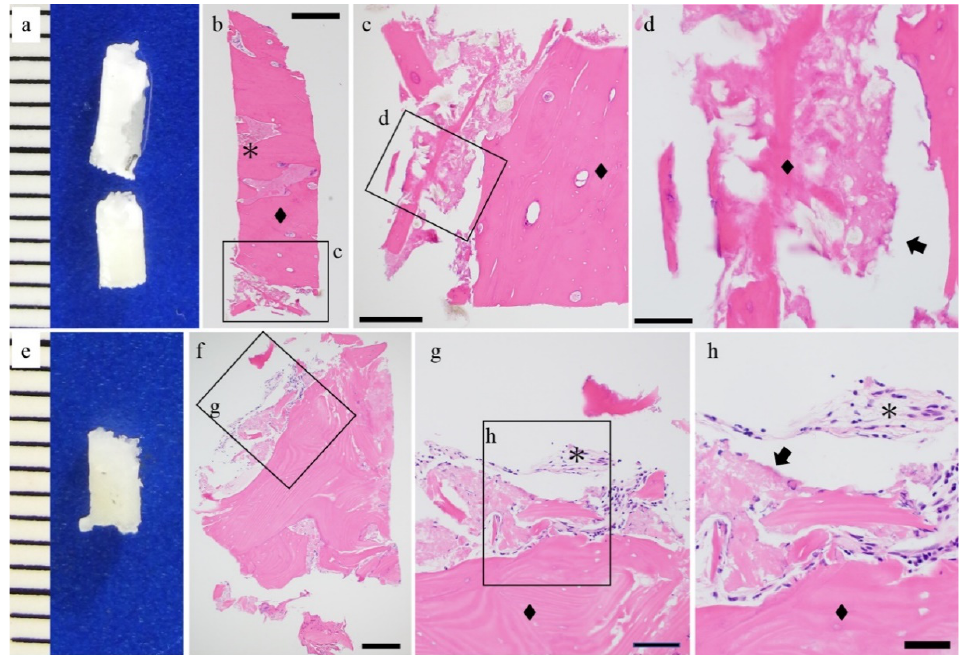
Figure 2. Histological findings of the u-HA/PLLA cases. ( a , e ) Macro findings and hematoxylin and eosin staining. ( b – d , f – h ) Hematoxylin and eosin staining. The hydroxyapatite/poly-l-lactide (u-HA/PLLA) screw (arrow) and bone ( (cid:7) ) are in direct contact. Connective tissue was observed (*). Bar: ( b ) 500 µ m, ( c , f ) 200 µ m, ( d , g ) 100 µ m, and ( h ) 50 µ